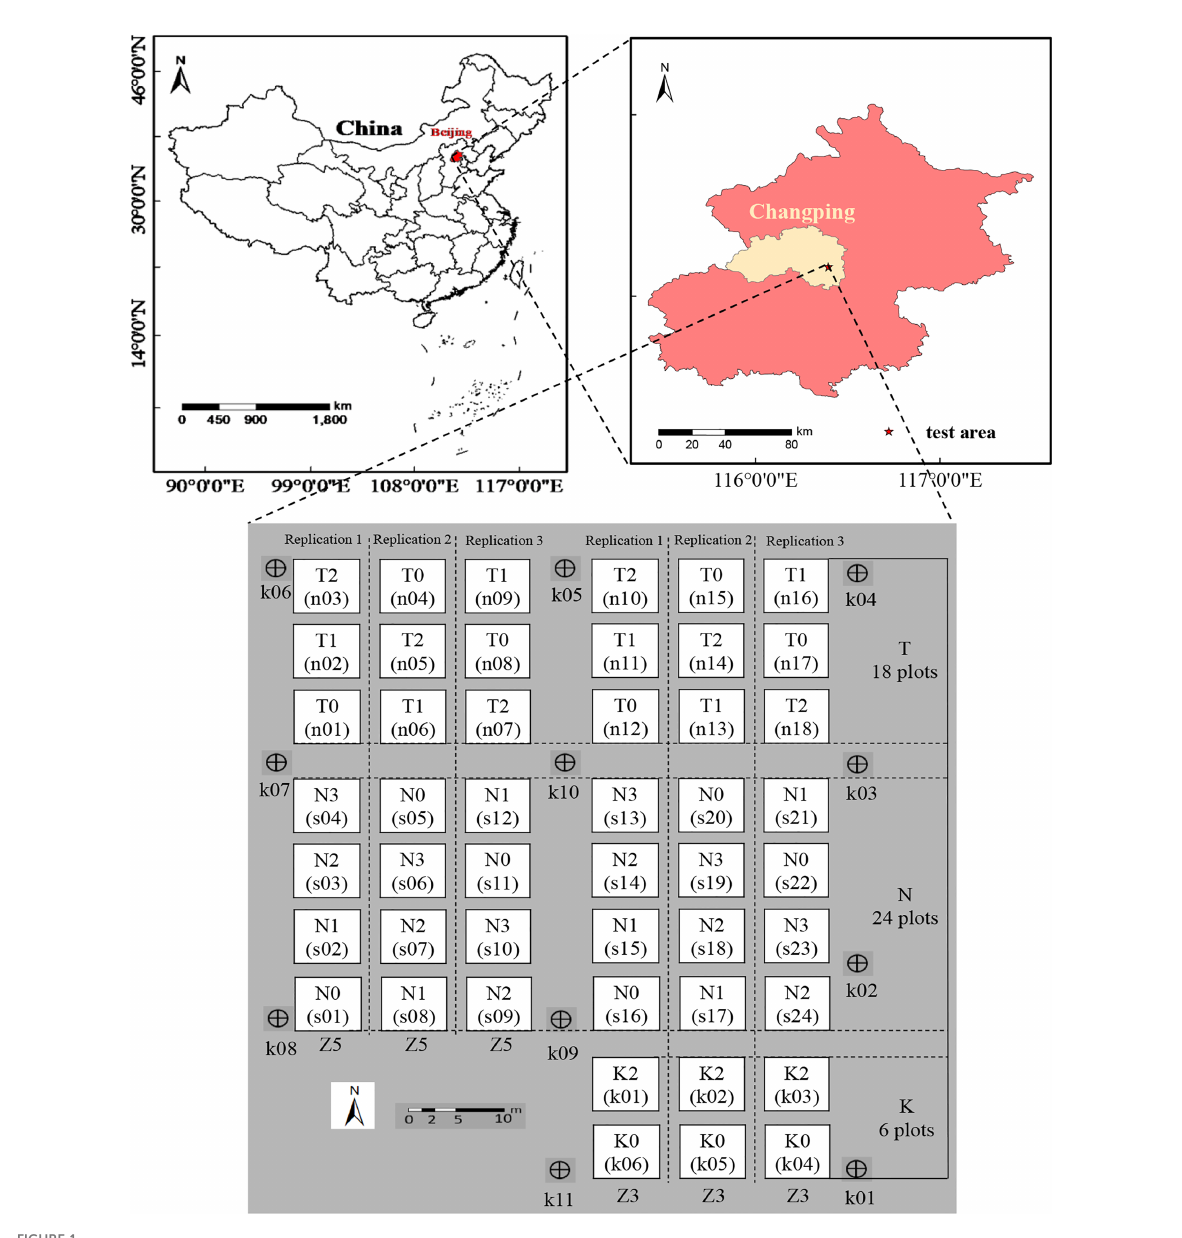
FIGURE 1 Potato fi eld location and experimental